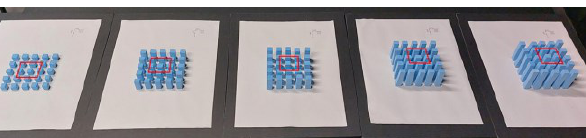
Figure 2 . The mixed surfaces we used to create dataset #2. The repetitive pattern in each surface is marked approximately with a red polygon. The heigh of the blue cubes varies from 1 cm (in the most left pattern) to 5 cm (in the most right pattern).